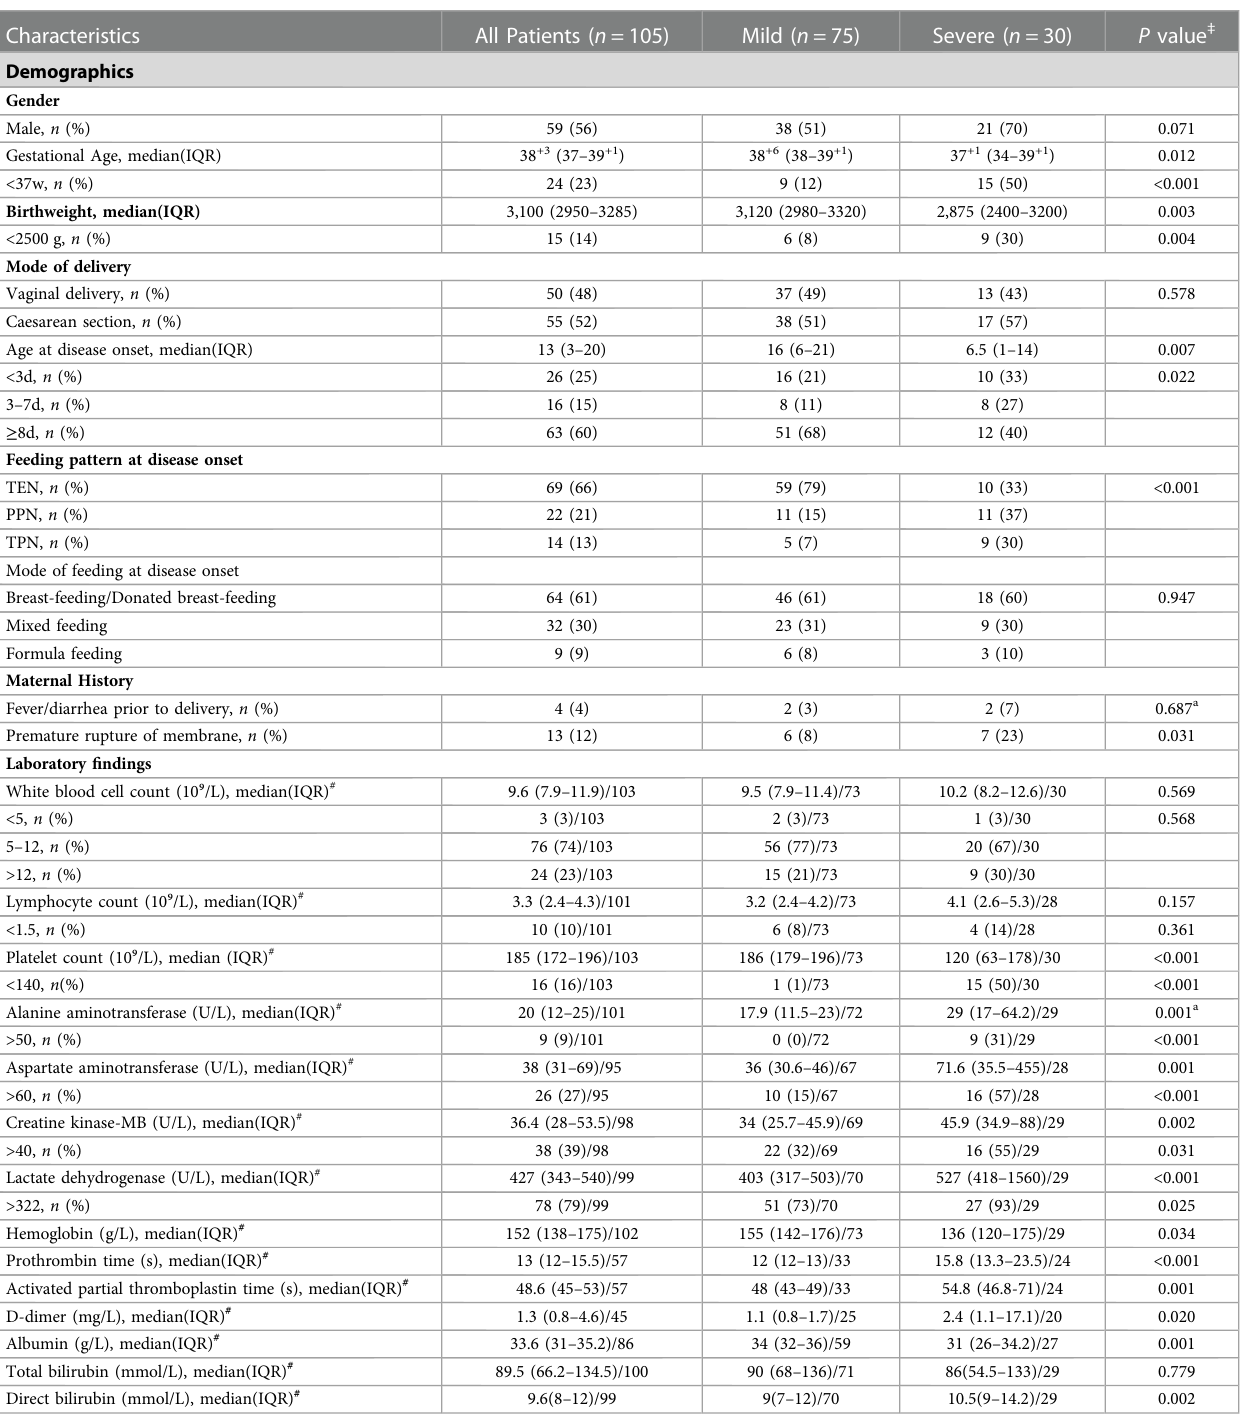
TABLE 1 Clinical characteristics of the study